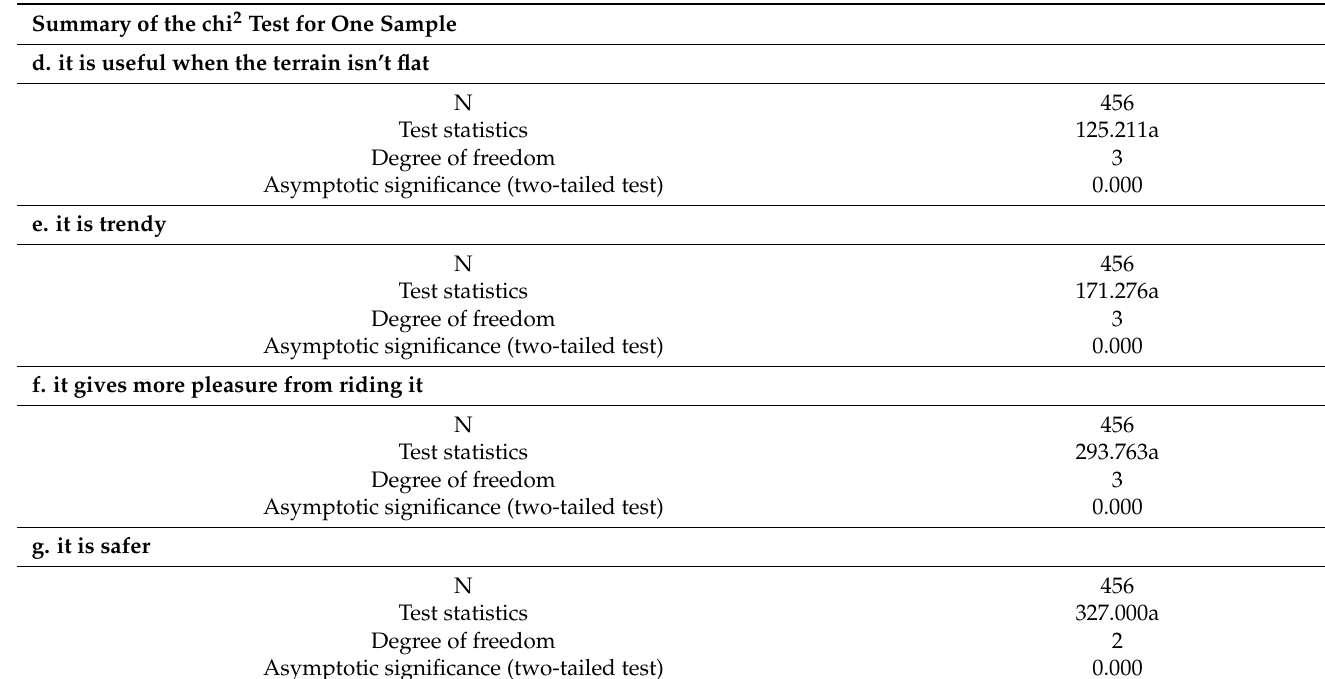
Summary of the chi 2 Test for One